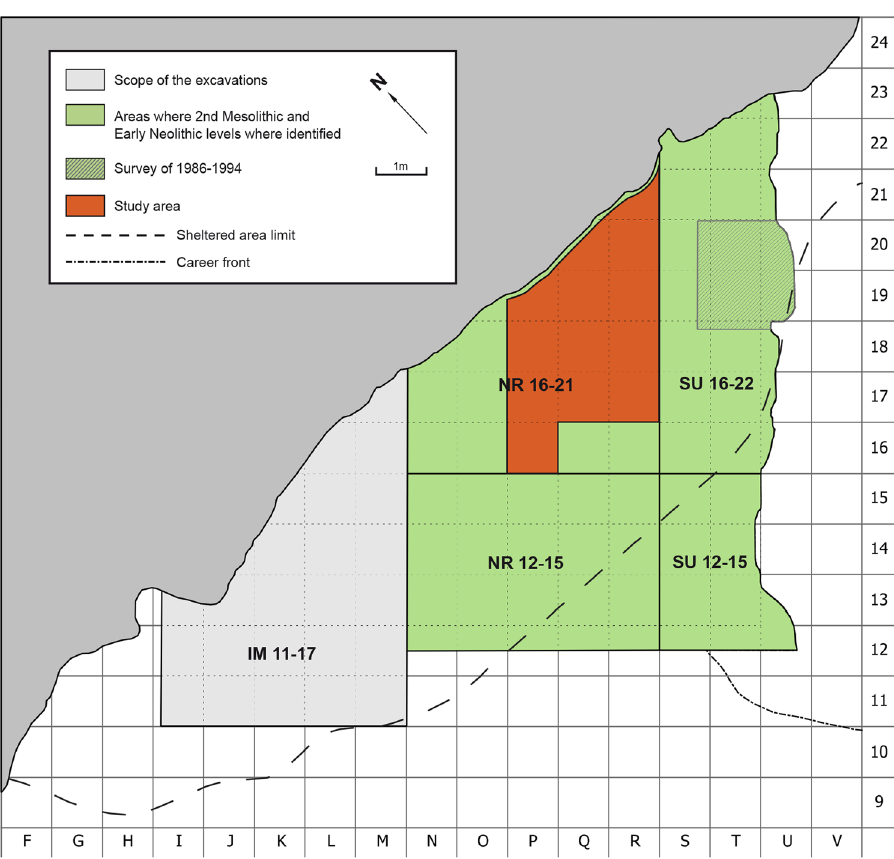
Figure 6: Localisation of the main excavation areas at La Grande Rivoire rock shelter and of our study area ( in orange ) . CAD: Cyril Bernard ( AVDPA ) ( modi fi ed from Nicod & Picavet, 2014 )